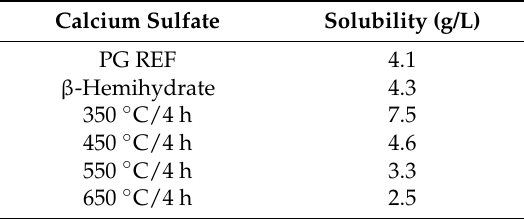
Table 7. Solubility of each calcium sulfate sample.